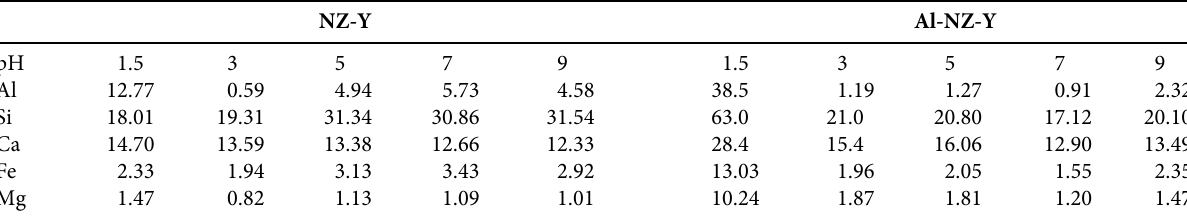
Table 3. Concentration(mg L –1 ) of metals dissolved from adsorbent into solution with varying pH after 3h- contact